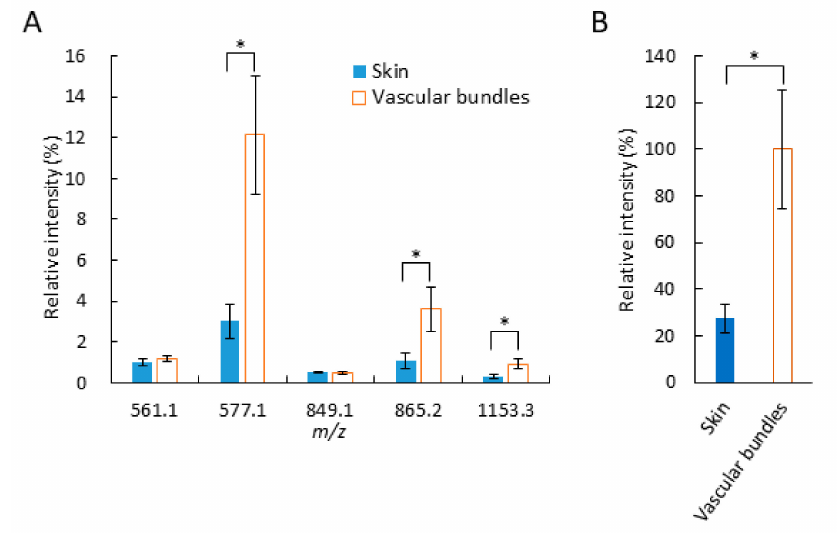
Figure 5. Relative intensities of identified flavan-3-ol species in the skin and in and around the vascular bundles of strawberry fruit sections. Relative intensities of ( A ) m / z 561.1, 577.1, 849.2, 865.2, and 1153.3, and ( B ) m / z 289.1. The mean relative intensities of each flavan-3-ol are shown as the relative intensity of the strongest m / z 289.1, (epi)catechin, in and around the vascular bundle, which was defined as 100%. The data are expressed as mean values ± standard deviation (n = 3). Statistical analyses were performed between in the skin and in and around the vascular bundles of the same flavan-3-ol species. Asterisks (*) indicate significant di ff erences between the mean values in the skin and in and around the vascular bundles, as determined by Mann–Whitney U test at the 5% significance